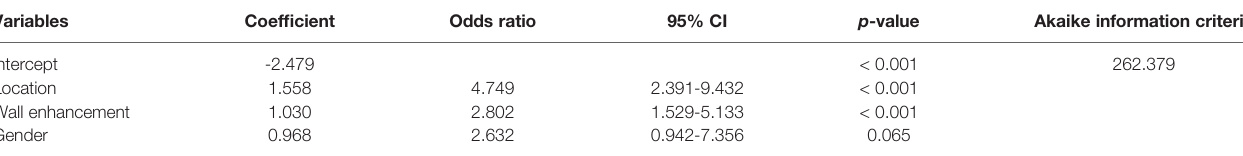
TABLE 5 | Parameters of the radiological model built in the full